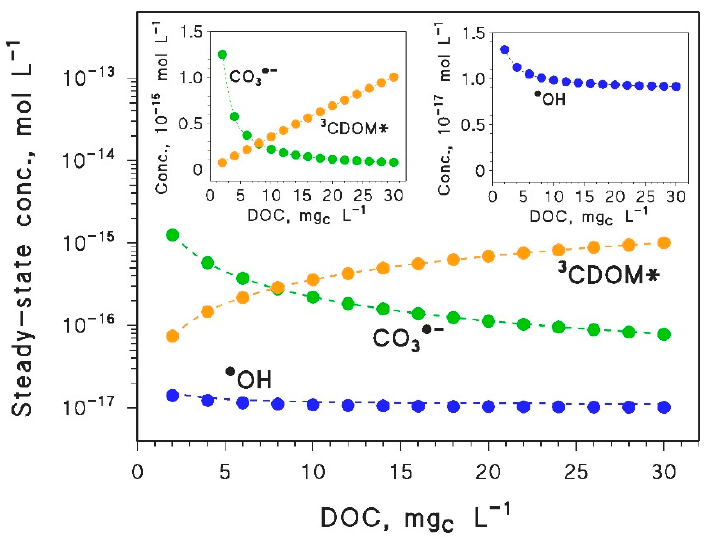
Figure 2. Modeled steady-state concentrations of • OH, CO 3 •− , and 3 CDOM* as a function of the DOC, for constant values of the product DOC × d th = 45 m mg C L − 1 . In the main figure panel, the y -axis has an exponential scale that gives insights into the orders-of-magnitude differences in concentrations. The same data are plotted with a linear y -axis scale in the two inserts, where one can appreciate the almost linear trend of [ 3 CDOM*] with the DOC. Note that 1 O 2 has similar concentration values and similar trends as 3 CDOM* [4]. Other water conditions: 10 − 4 mol L − 1 NO 3 − , 10 − 6 mol L − 1 NO 2 − , 10 − 3 mol